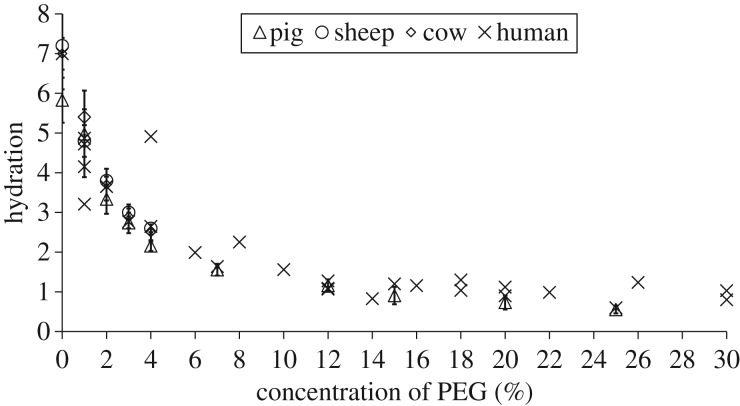
The relationship between the concentration of PEG in the bathing medium and the equilibrated stromal hydration in each species. Data for porcine, ovine and bovine corneas are shown as average values with standard deviation bars based on n = 5 at each data point. Data for human corneas represent a single specimen at each concentration. See the electronic supplementary material, S2 for tabulated data format.